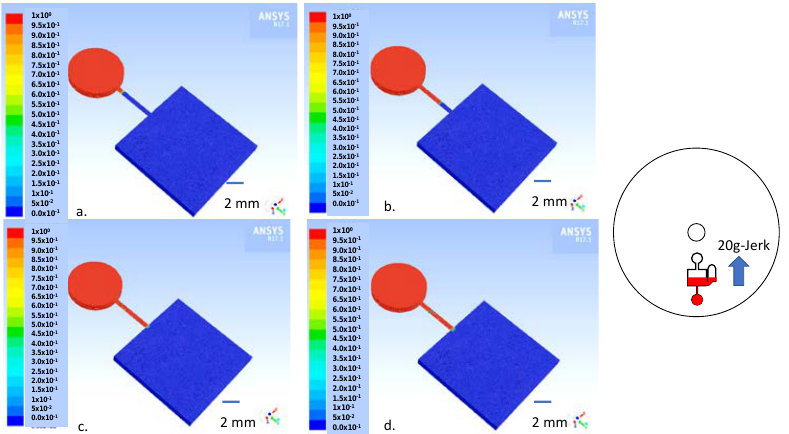
Figure 8. The results of two-phase flow Fluent simulation (going from stop frame ( a – d )) that models the jerk acceleration of 20 g directed toward the disc’s center (see the inset illustration) where the red blood cells that are separated in the rectangular RBC chamber (red) do not enter into the reciprocation chamber that is filled with supernatant plasma (blue) as the red blood cells are pinned at the connecting channel—reciprocation chamber junction.